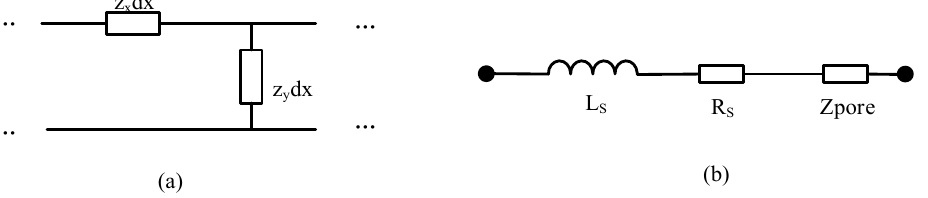
Figure 13. Porous electrode model: ( a ) trapezoidal equivalent model; ( b ) porous equivalent circuit model of double-layer supercapacitor.